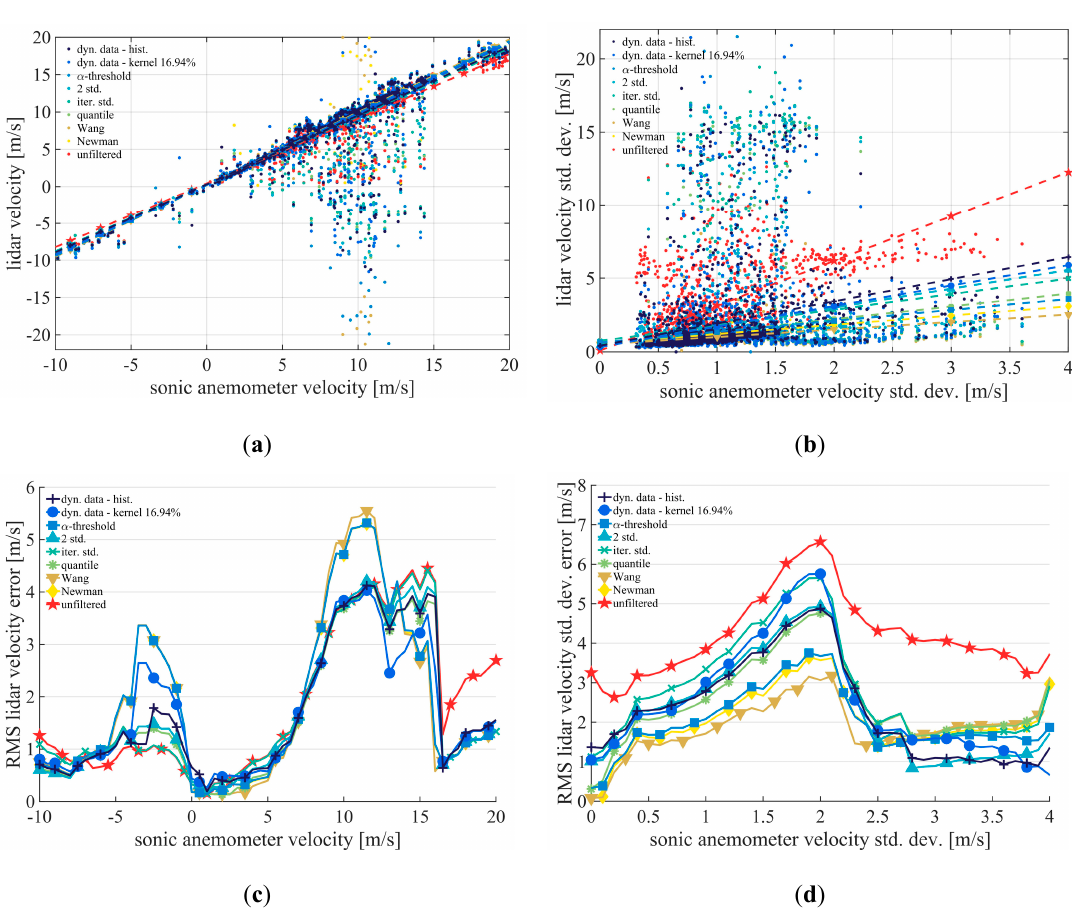
Figure 13. Behaviour of the 10 min averaged filtered staring mode measurements of ( a ) the projected wind speed over time, ( b ) the standard deviation over time, ( c ) average wind speed error over time, ( d ) standard deviation error over time.